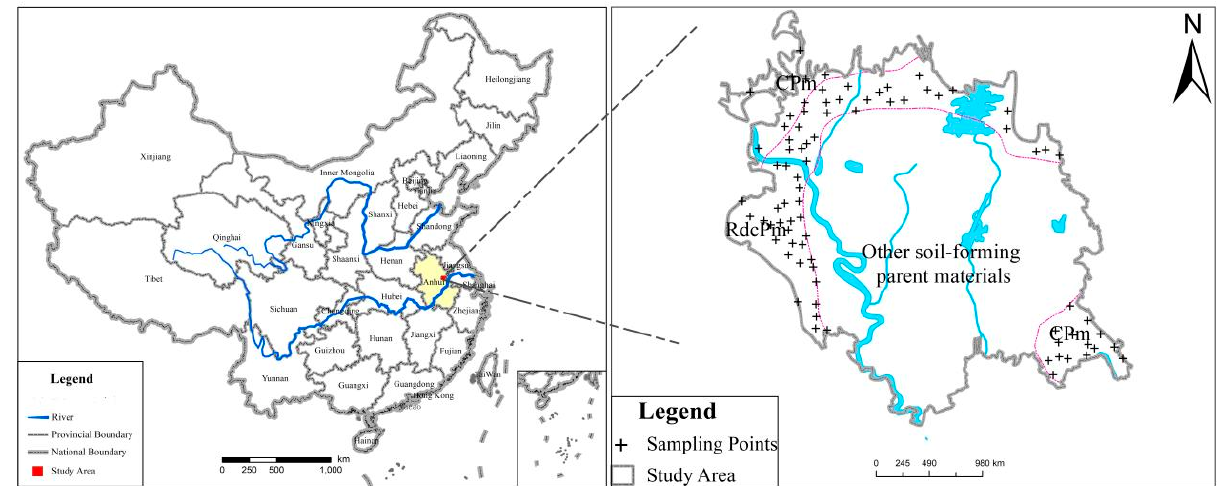
Figure 1. Geographical location of the study area and spatial distribution of sampling points.